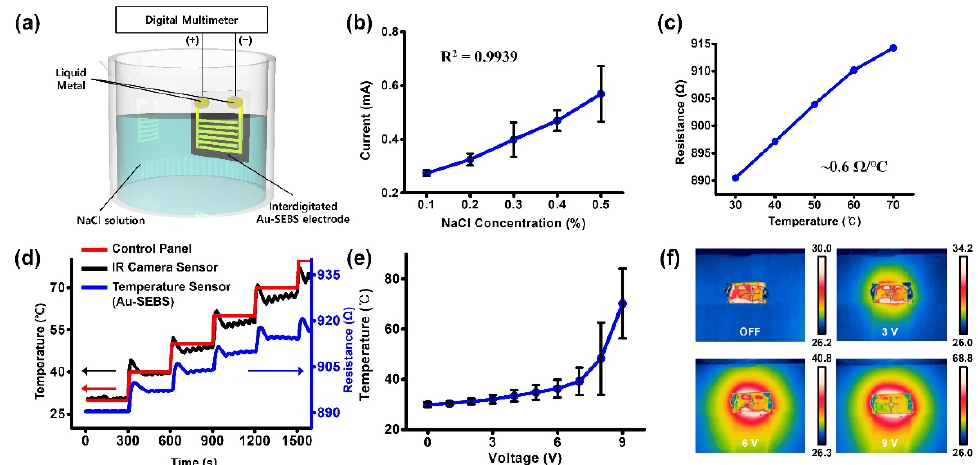
Figure 5. ( a ) Measurement setup of the Au–SEBS electrochemical sensor. ( b ) NaCl sensing of the electrochemical sensor. ( c ) Temperature–resistance correlation of Au–SEBS temperature sensor. ( d ) Real temperature differences between the control panel of a hot plate machine and IR camera sensor and the temperature sensing of the Au–SEBS temperature sensor in real time. ( e ) Heating performance of the heater following the voltage. ( f ) Thermal imaging of the Au–SEBS electrode heater in the off state, 3 V, 6 V, and 9 V with scale bars.